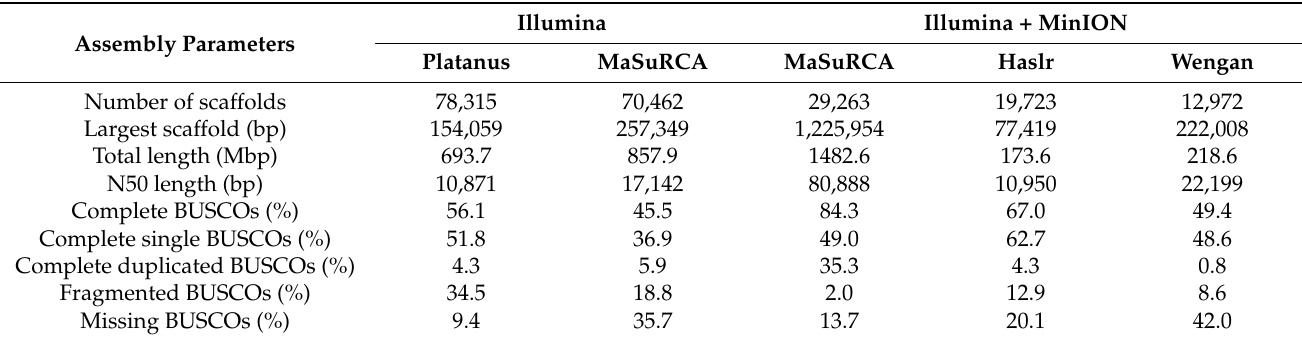
Table 3. Relevant assembly and BUSCO statistics for the assemblies of the rooibos genome generated using Illumina and MinION sequencing data with short-read and hybrid assembly programs.